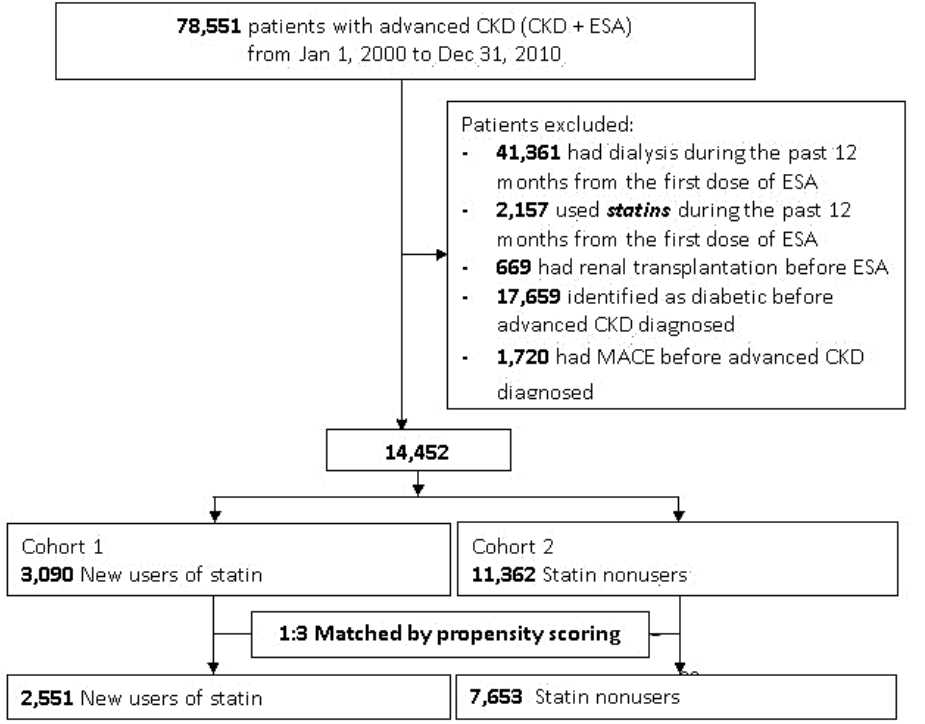
Figure 1. Detailed flowchart for patient enrollment. Abbreviations: CKD, chronic kidney disease; ESA, erythropoiesis-stimulating agents; MACE, major adverse cardiac events.